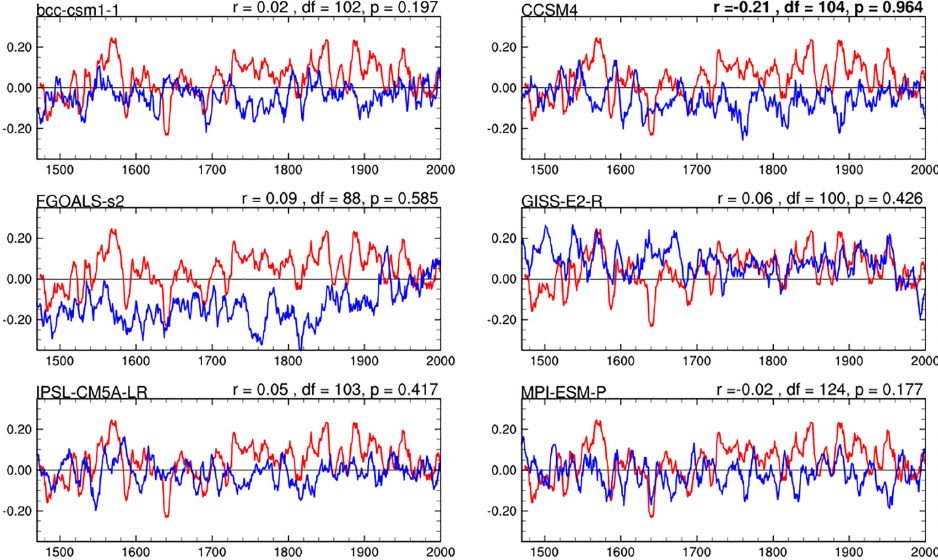
Figure 7. Comparison of the reconstructed 9-year running mean (red line) and six simulated (blue line) MJJAS mean precipitation anomalies for China during the interval